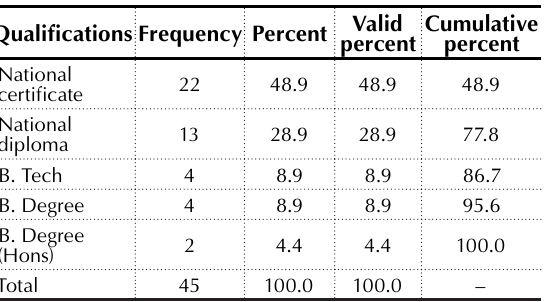
Table 1. Responses on qualifications